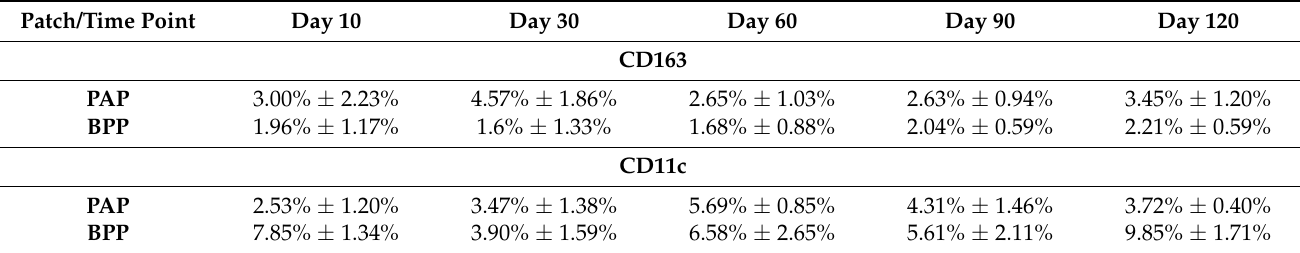
Figure 8. Results of the histomorphometrical analysis of the occurrence of pro- and anti-inflammatory cells (* = interindividual significances, # = intraindividual significances, # p < 0.05, ** = p < 0.01, ***/### p < 0.001). PAP: porcine aortic patch, BPP: bovine pericardial patch, blue: PAP-CD163, red: BPP-CD163, blue patterned: PAP-CD11c, red patterned: BPP-CD11c. Table 1. Histomorphometrical results of the percentages of pro- and anti-inflammatory cells in the implant beds of the porcine aorta patch (PAP) and the bovine pericardial patch